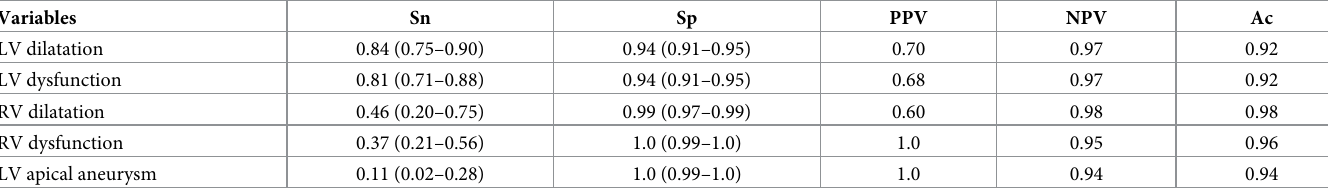
Table 4. Accuracy of FoCUS versus Standard Echocardiography in patients with Chagas disease from the Sami-Trop cohort. Variables